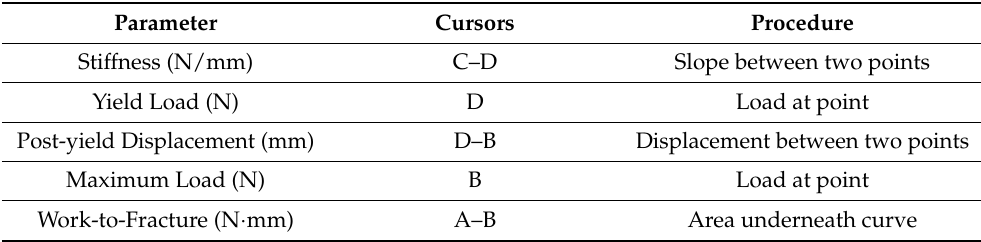
Table 2. Whole-bone biomechanical properties measured in the present study and their procedures of measurement with respect to Figure